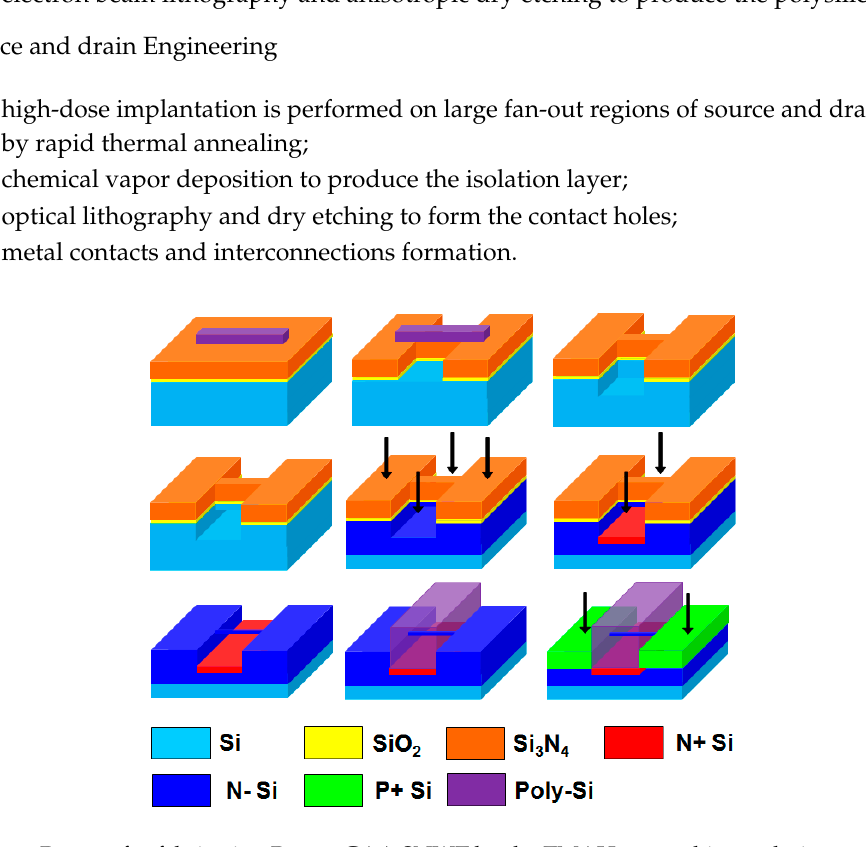
Figure 8. ( a ) SEM image of multiple suspended silicon nanowires formed by TMAH etching; ( b ) TEM image of silicon nanowires after gate oxidation and polysilicon gate deposition.